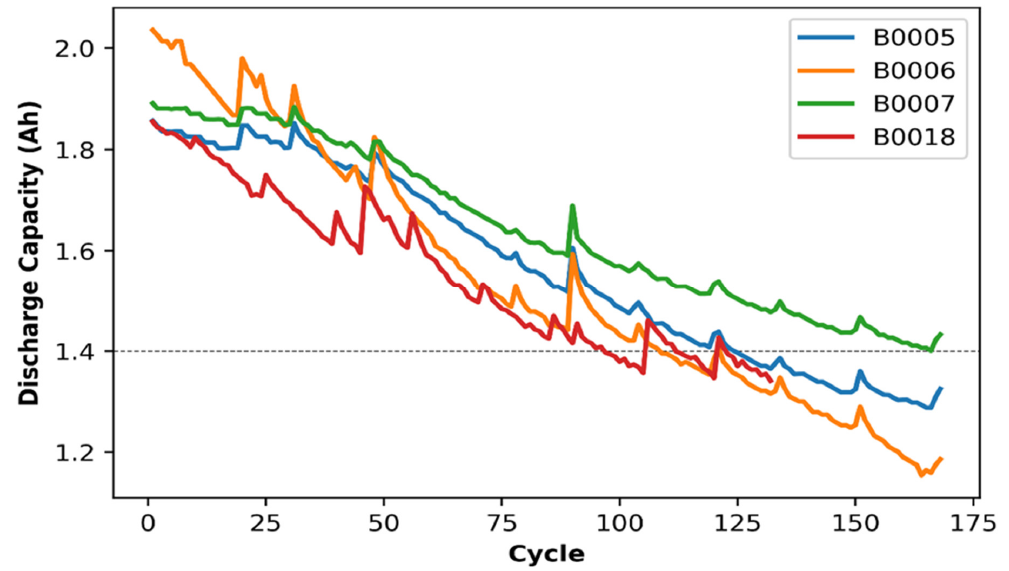
Figure 5. The discharge capacities of selected batteries corresponding to the respective discharge cycles. Table 2. Features corresponding to discharge profile in the Li-ion battery dataset.